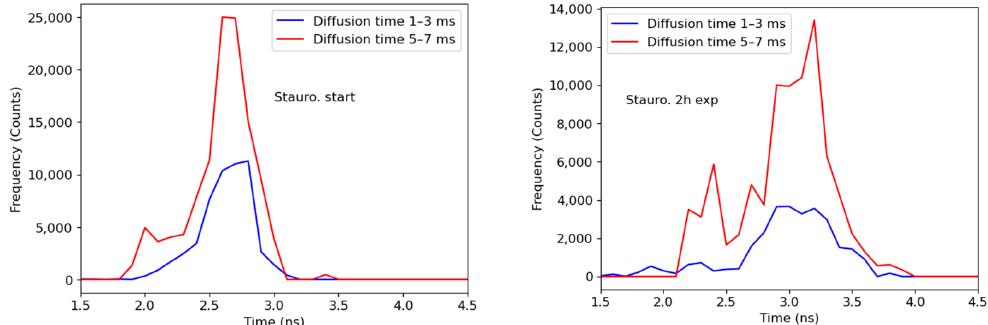
Figure 4. Distribution of average lifetimes with diffusion times in the range of 1–3 ms (6 points, blue) and 5–7 ms (8 points, red) in the vicinity of ± 3 pixels of the FCS measurement points. Left—at the and 5–7 ms (8 points, red) in the vicinity of ±3 pixels of the FCS measurement points. Left—at the time of the addition of staurosporine; right—2 h after the addition of time of the addition of staurosporine; right—2 h after the addition of staurosporine.